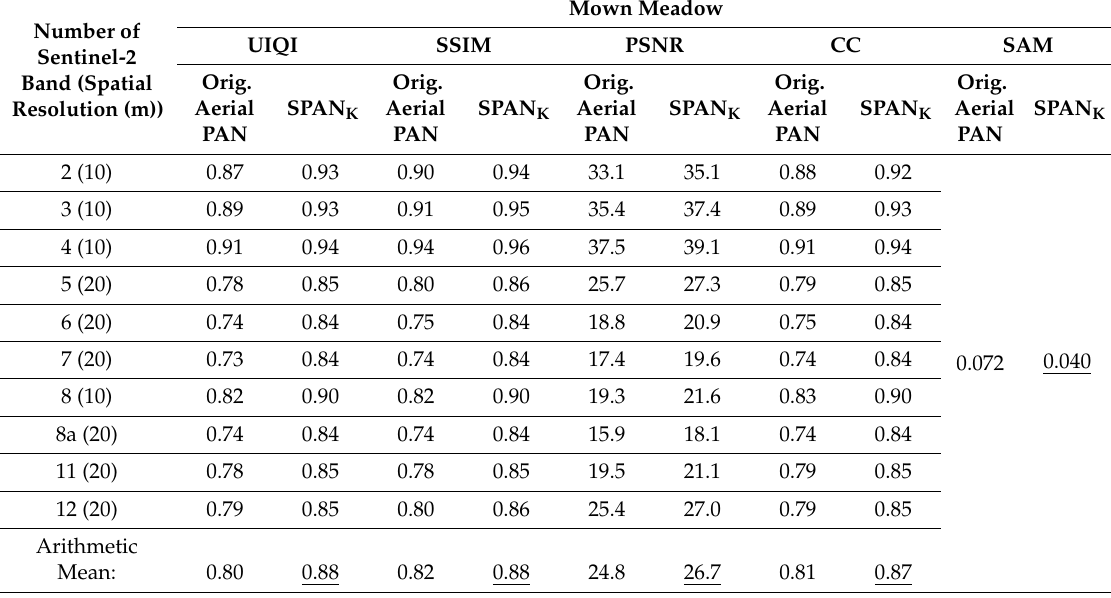
Table 3. Spectral quality values for the mown meadow sample (the best results are